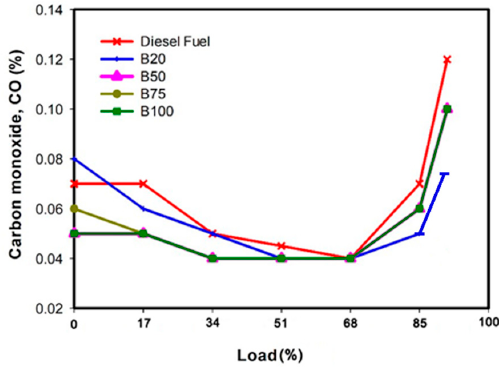
Figure 10. Variations of CO with engine load for diesel, sheep fat biodiesel (B100) and biodiesel blends (B20, B50 and B75) fuels. blends (B20, B50 and B75)